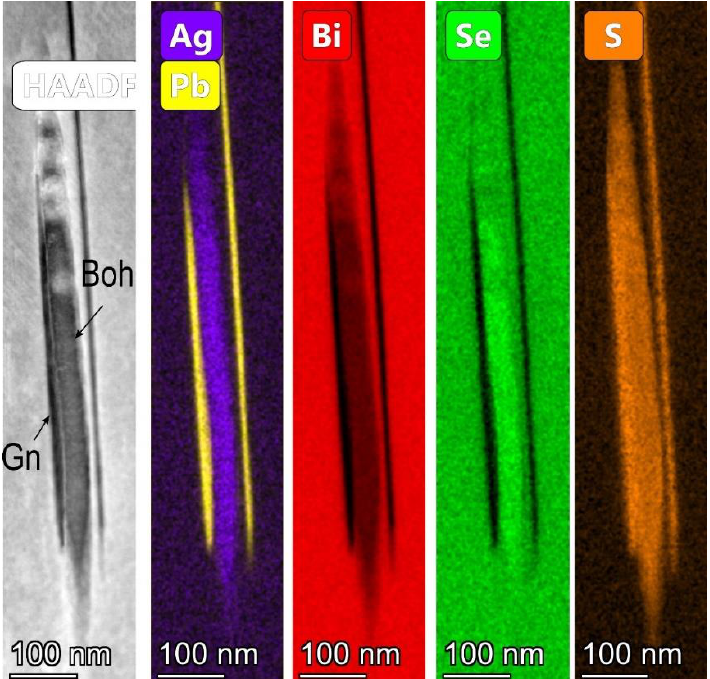
Figure 12. STEM EDS element maps showing an acicular inclusion comprising bohdanowiczite (Boh) between two needles of galena (Gn).